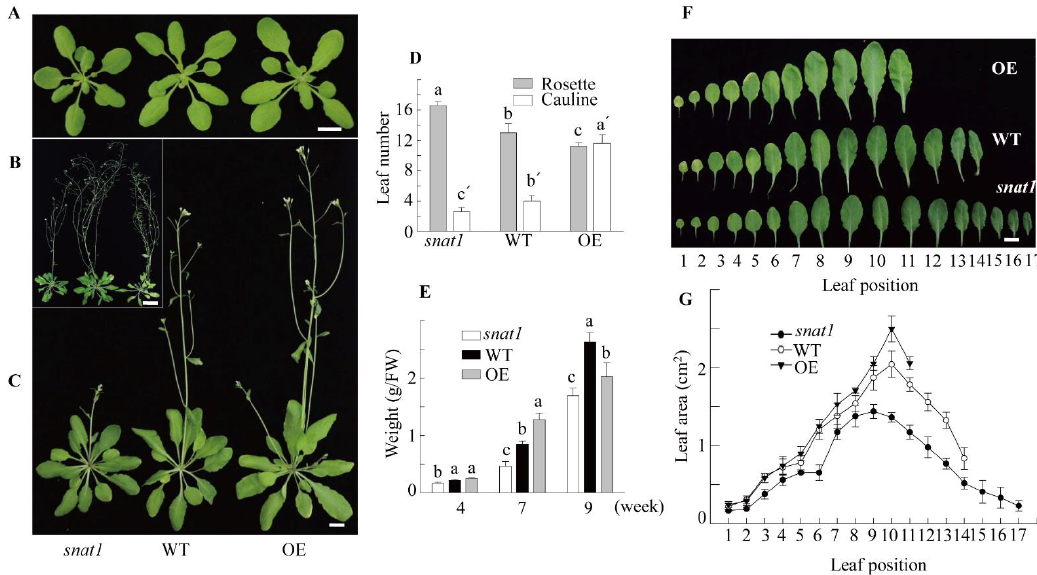
Figure 1. ( A ) Rosette or ( B ) flowering, ( C ) phenotype of wild type (WT) (Col-0), snat1 , and SNAT1 overexpression (OE) Arabidopsis lines. Plants were grown for four ( A ), nine ( B ), or seven weeks ( C ) under 50 μmol m -2 s -1 light conditions. ( D ) The flowering times of Arabidopsis were denoted as the total number of rosette and cauline leaves averaged over five independent plants. ( E ) Fresh weights of the WT, snat1 , and OE lines 4–9 weeks after planting. ( F ) Representative rosette leaves from the WT, snat1 , and OE lines after the OE line had started to bolt. ( G ) Rosette leaf areas of each leaf position in the WT, snat1 , and OE lines, measured at the same time as in F. Scale bar: 1 cm ( A , C , F ) and 3 cm ( B ). Different letters indicate significant differences between groups (small letters or small letters with an apostrophe) (Tukey’s post hoc HSD test; p < 0.05). SNAT1 encodes the gene with